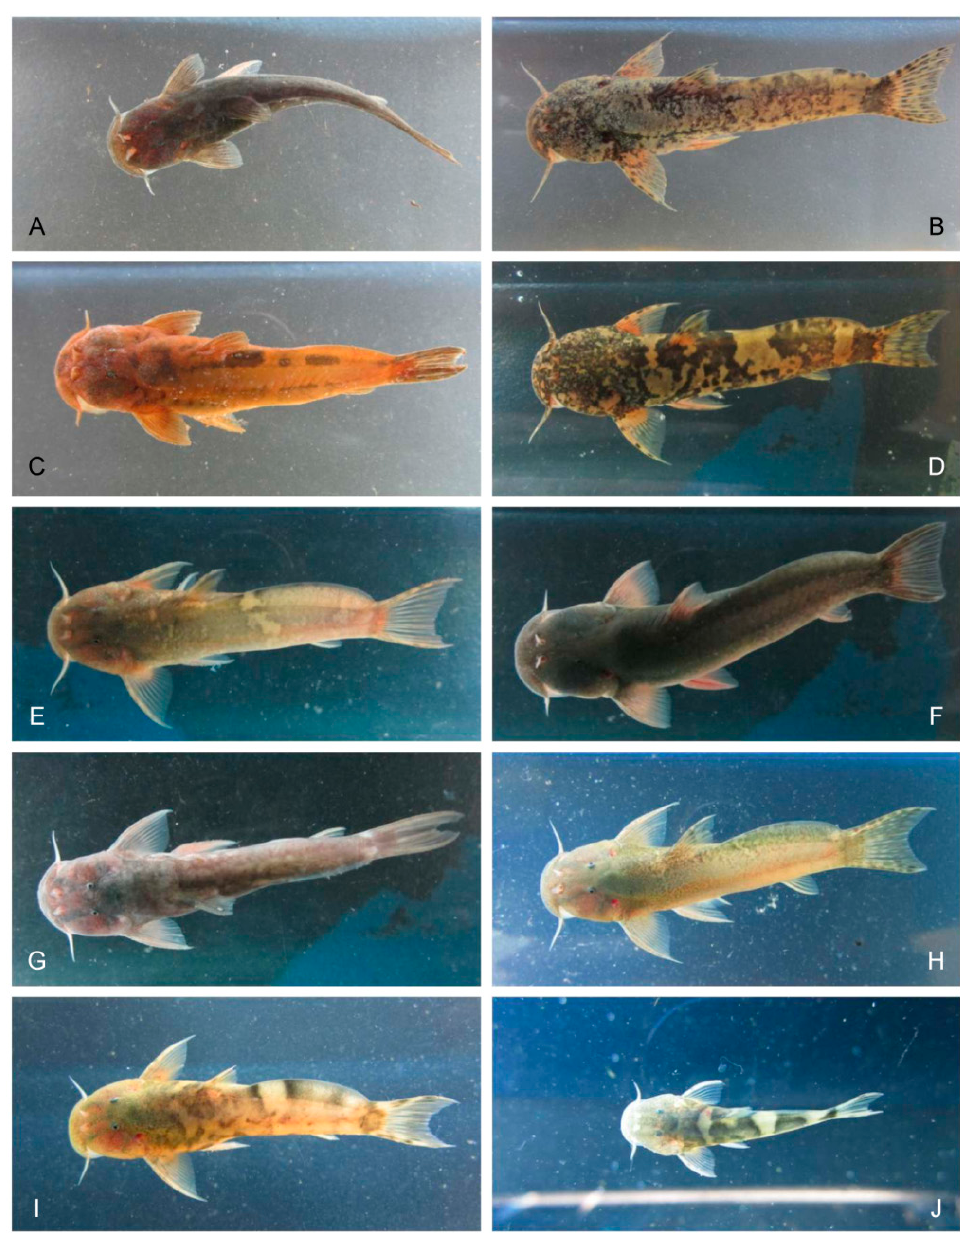
Figure 5. Species and morphotypes of genus Astroblepus collected in the upper Madre de Dios River. ( A ) Astroblepus sp.2 collected on Américo stream (21Q), ( B ) Astroblepus sp.1 collected on Unión River (20R), ( C ) Reddish specimen of Astroblepus sp.1 collected on Unión River (20R), ( D ) Astroblepus sp.1 collected on San Pedro River (19R), ( E ) Astroblepus mancoi collected on San Pedro River (19R), ( F ) Astroblepus sp.2 collected on San Pedro River (19R), ( G ) Astroblepus sp.1 collected on Quitacalzon stream (17Q), ( H ) Astroblepus aff. longifilis collected on Kosñipata River (16R), ( I ) Astroblepus mancoi collected on Queros River (13R), and ( J ) Astroblepus aff. trifasciatus collected on Salvación River (12R).